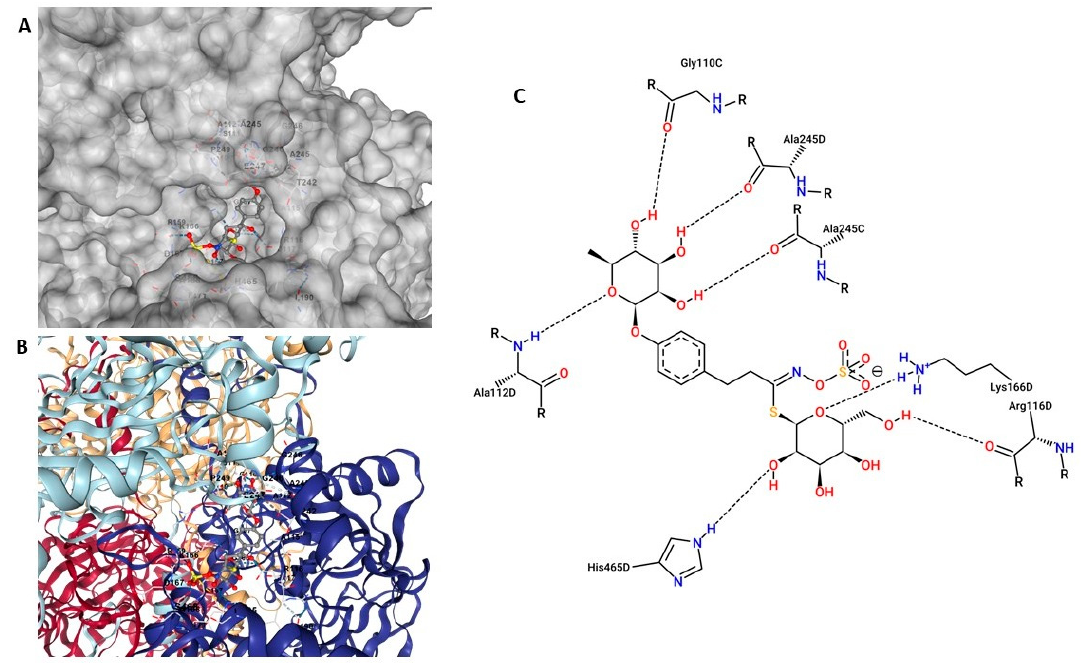
Figure 8. Docking results of the glucomoringin–catalase complex. The binding site of the complex in space-filling view ( A ) and ribbon view ( B ), and the amino acids and chemical bonds involved in the interaction with catalase in a PoseView 2D interaction diagram ( C ).